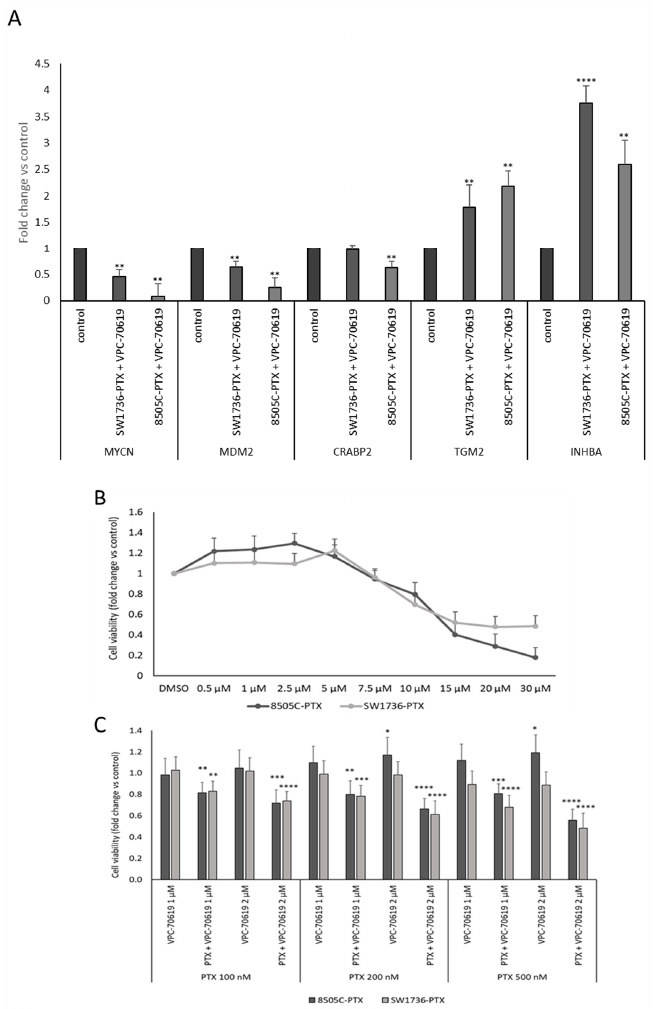
Figure 8. Panel ( A ): SW1736-PTX and 8505C-PTX cells were treated with VPC-70619 (SW1736-PTX + VPC-70619 and 8505C-PTX + VPC-70619) or with DMSO as vehicle (control), after mRNA levels of some MYCN targets were evaluated by real-time PCR after following retro transcription. Control was arbitrarily set at 1.0. n = 3. * p < 0.05, ** p < 0.01, *** p < 0.001, **** p < 0.0001. Panel ( B ): 8505C and SW1736 paclitaxel-resistant (8505C-PTX and SW1736-PTX) cells were treated with VPC-70619 at different doses (rising from 0.5 µ M to 30 µ M) or vehicle (DMSO) for 72 h and cell viability was assessed by MTT assay. Panel ( C ): 8505C-PTX and SW1736-PTX were treated with VPC-70619 at two different concentration (1 or 2 µ M) in combination with paclitaxel (PTX) at three different concentrations (100, 200, or 500 nM) for 72 h. Cell viability data are obtained by MTT assay. Each point represents the mean of six measurements. n = 6. Panel ( A ) p -values are listed in Supplementary Table